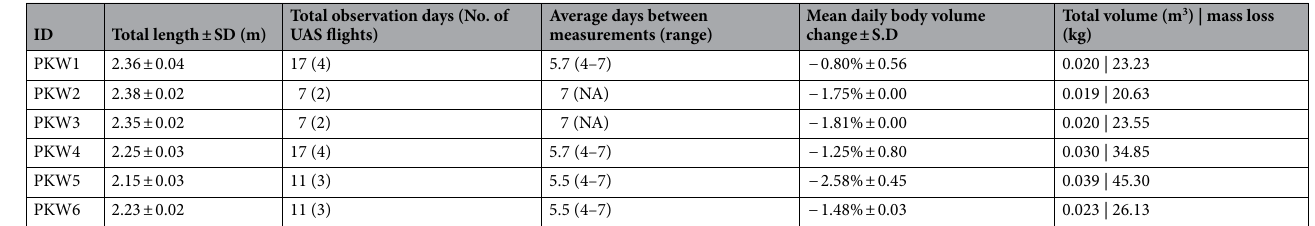
Table 2. Changes in body volume (m 3 ) of six pygmy killer whales obtained using unoccupied aerial systems (UAS)-photogrammetry during a NOAA Fisheries response to a prolonged stranding event that took place from September 13 to October 3, 2019 in the nearshore waters of Ma ʻ alaea Bay, Maui.